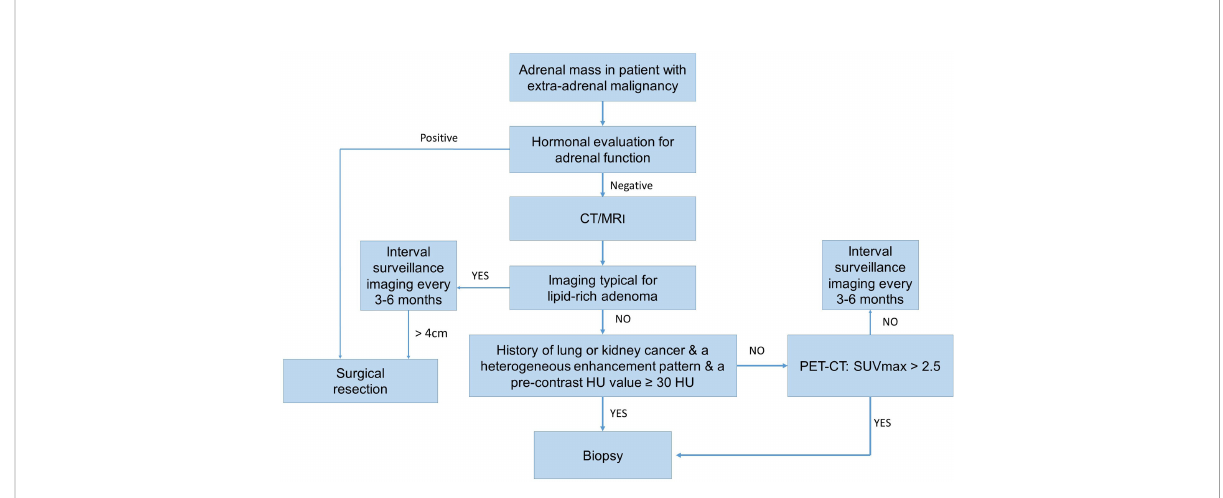
FIGURE 2 The operative fl ow-chart for evaluation of an adrenal mass in patient with extra-adrenal